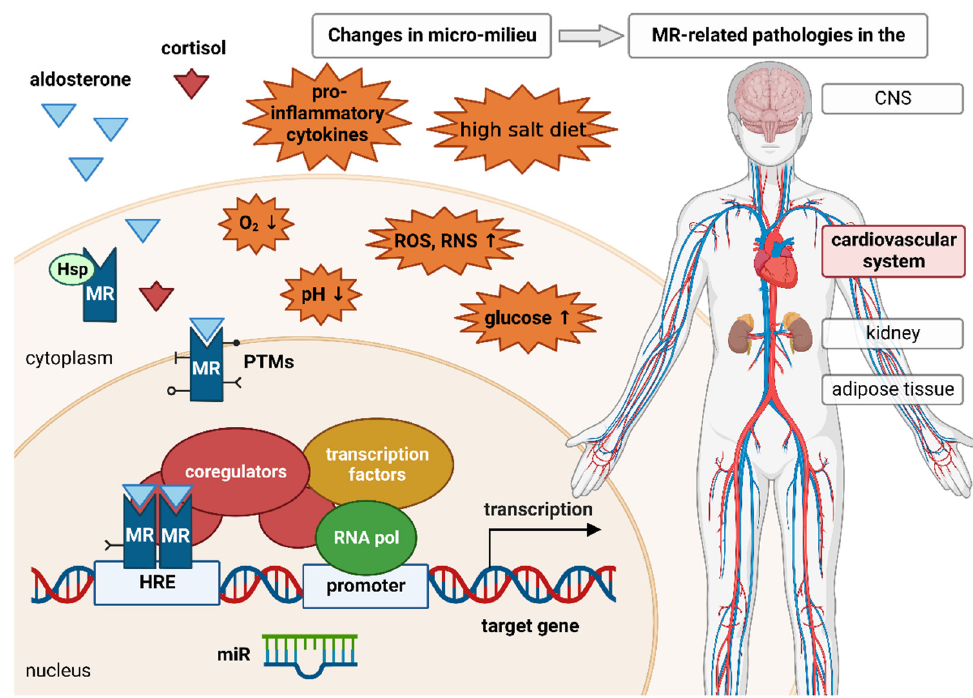
Figure 1. Prior to ligand binding, the mineralocorticoid receptor (MR) is located in the cytoplasm. Its conformation is stabilized by different heat shock proteins (Hsp) and immunophilins. Upon binding of its ligand aldosterone, the receptor is translocated to the nucleus. The MR is also able to bind the glucocorticoid cortisol. In the nucleus, the receptor either homodimerizes with another ligand ‐ bound MR or heterodimerizes with the glucocorticoid receptor (GR) and binds to the hormone response element (HRE), thereby enabling expression of MR target genes. Similarly to other steroid receptors, the MR recruits several coregulators that enhance or repress MR ‐ induced gene expression. MR stability, activity, and signaling are regulated by various posttranslational modifications (PTMs), such as ubiquitination, sumoylation, phosphorylation, acetylation, and oxidation. Micro ‐ RNAs (miR) are able to negatively regulate the expression of the MR as well as several MR target genes. The MR is involved in various pathologies affecting the kidney, central nervous system (CNS), adipose tissue, and, most importantly, the cardiovascular system. These pathologies cannot be exclusively attributed to changes in MR expression or aldosterone concentration. An altered cellular micromilieu due to inflammation, ischemia/hypoxia, oxidative stress, high salt intake, or elevated glucose concentrations can also affect MR signaling. These micromilieu changes can influence the expression of or interaction with several coregulators, miRs, and enzymes responsible for different PTMs, thereby contributing to pathological MR effects.